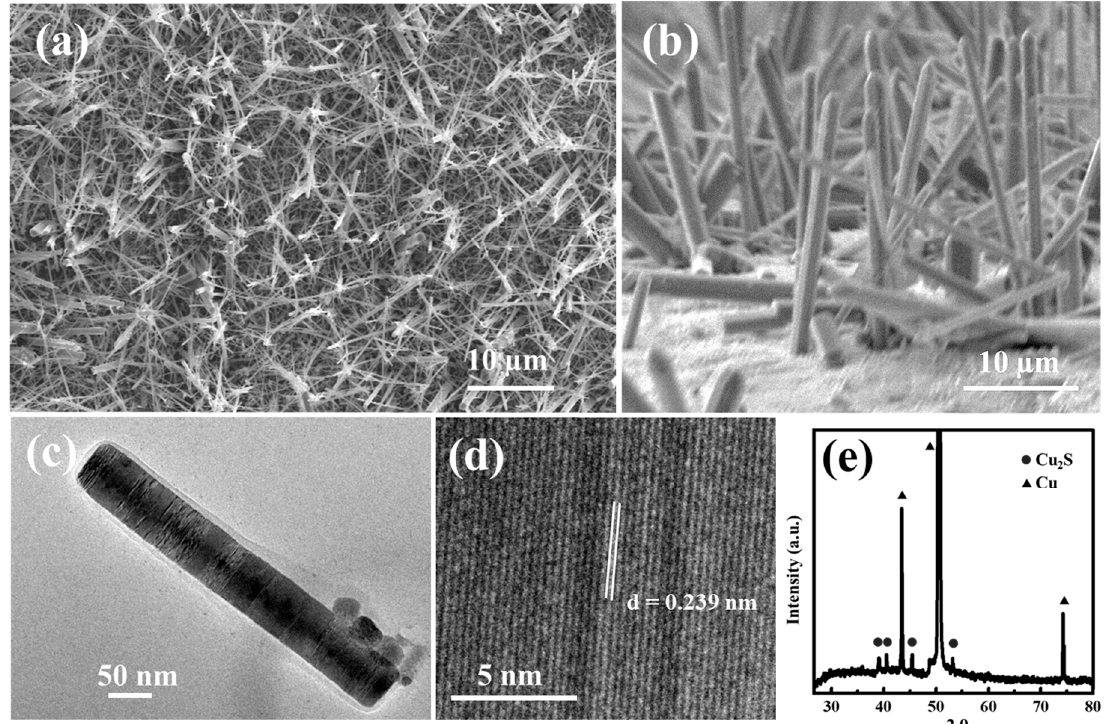
Figure 3. Structural characterizations of Cu 2 S nanowires. The top-view ( a ) and tilt-view ( b ) SEM images of Cu 2 S nanowires. ( c ) High-magnification and ( d ) high-resolution TEM image of Cu 2 S nanowires. ( e ) The XRD patterns of Cu 2 S nanowires.